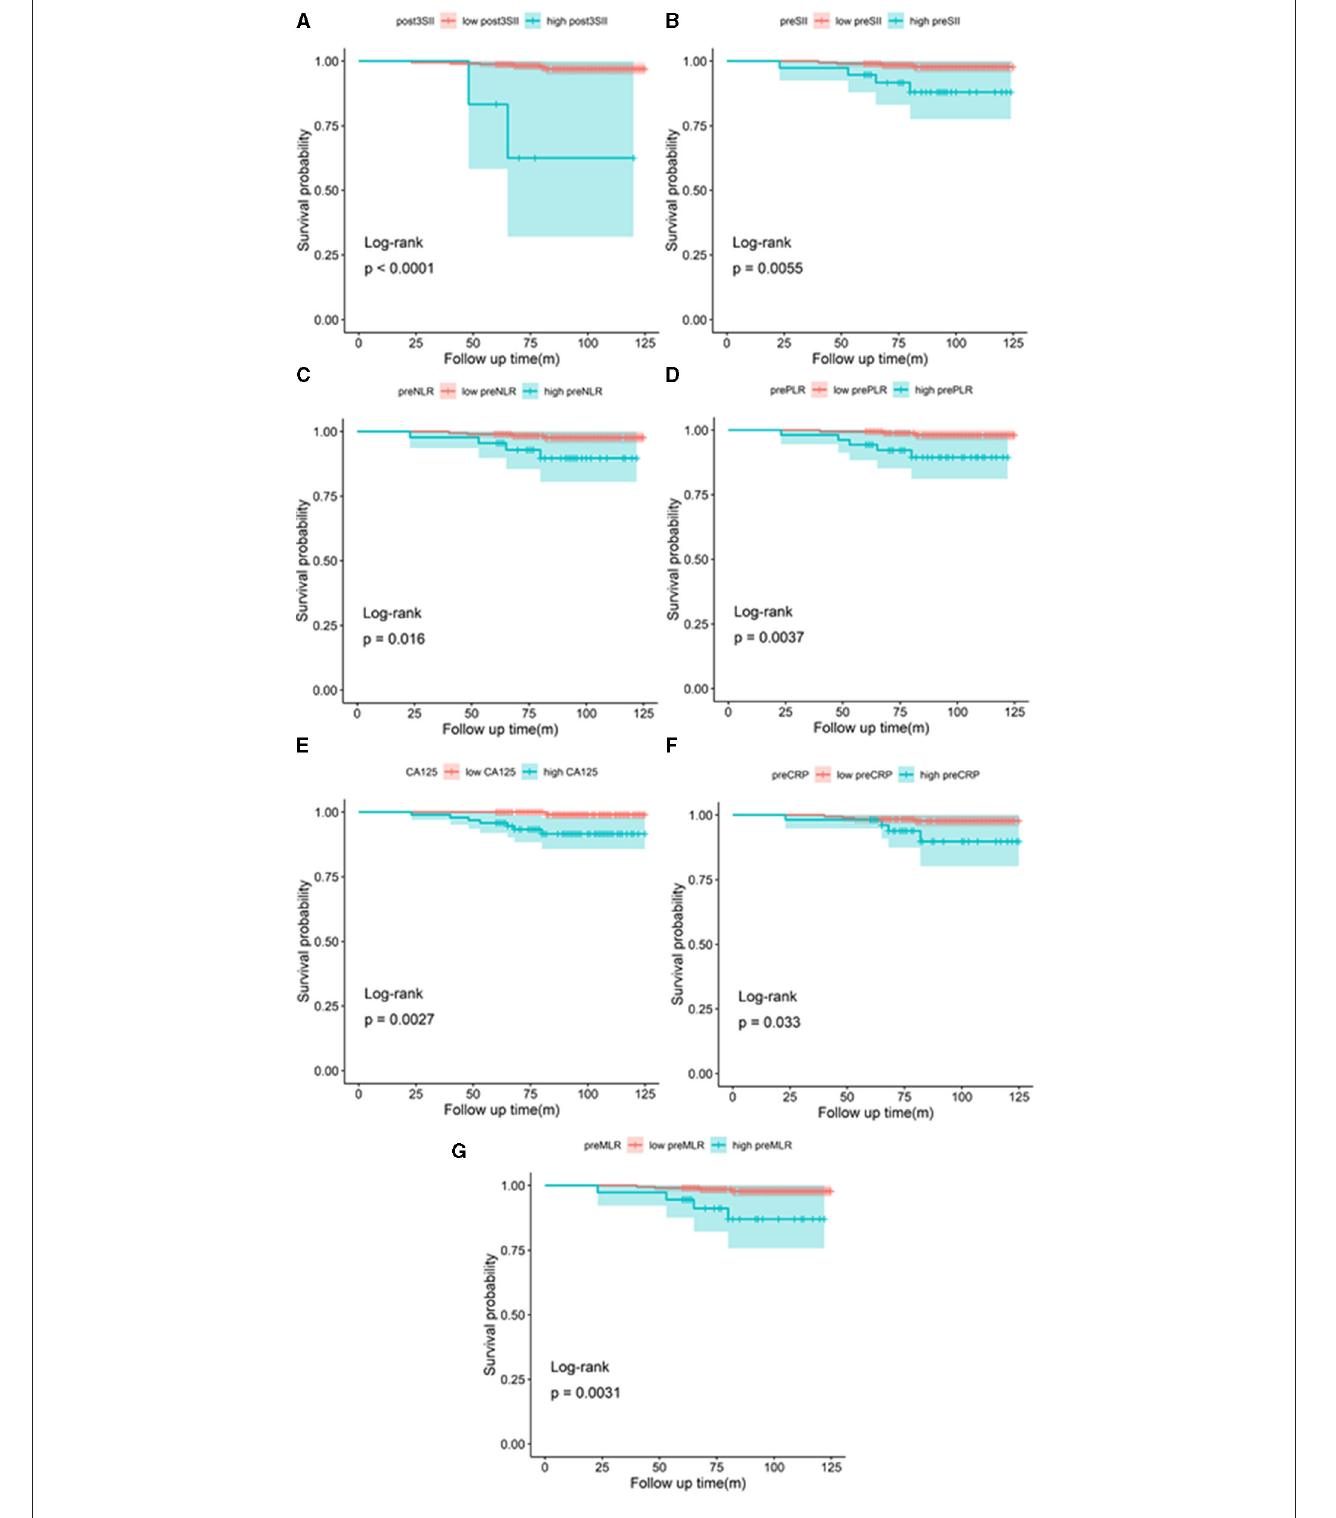
FIGURE 3 | Kaplan–Meier curves of OS according to the postoperative SII (A) , preoperative SII (B) , NLR (C) , PLR (D) , CA125 (E) , CRP (F) , and MLR (G) .